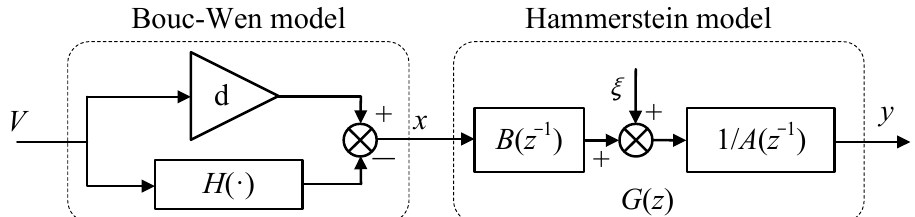
Figure 4. Block diagram of BW-H model.